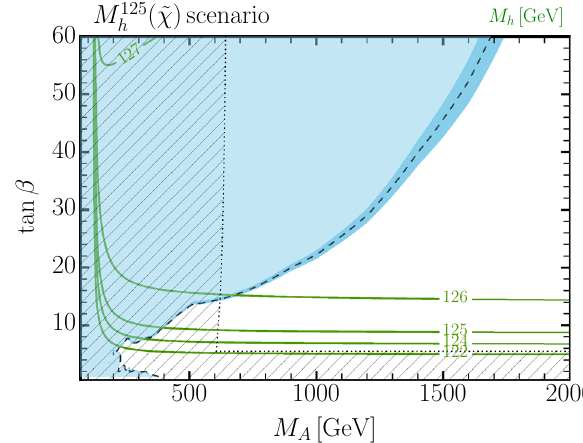
( ˜ χ) scenariofromHiggssearchesatthe Fig. 5 Constraintsonthe M 125 h LHC, in the ( M A , tan β) plane. The green solid lines are predictions for the mass of the lighter CP -even scalar h , the hatched area is excluded by a mismatch between the properties of h and those of the observed Higgsboson,andtheblueareaisexcludedbythesearchesforadditional Higgs bosons (the darker-blue band shows the theoretical uncertainty of the exclusion)